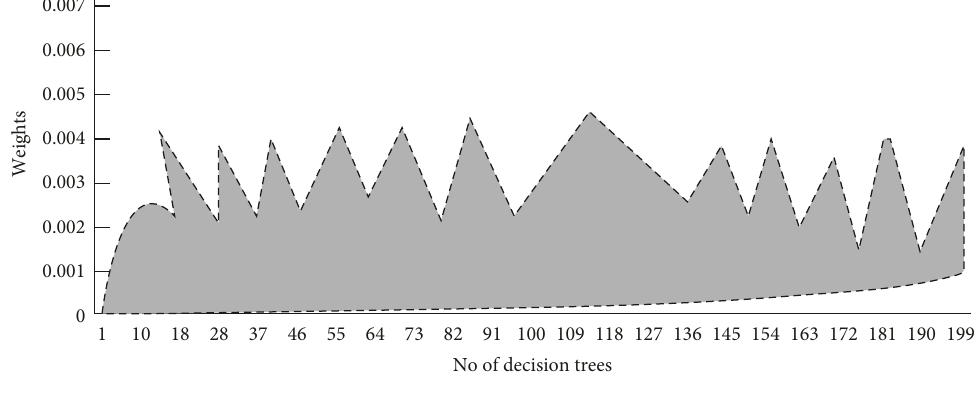
Figure 5: Decision tree weight diagram of weighted random forest. Table 2: Maximum similarity of the identification with different lengths and 999 random